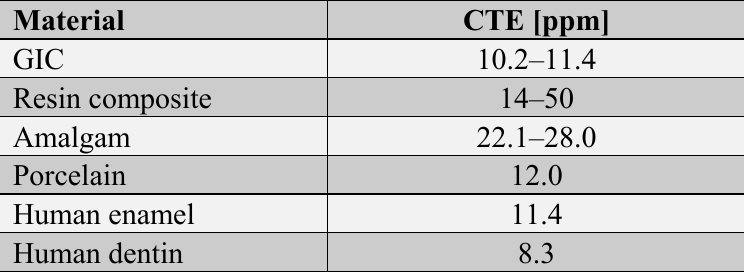
Table 2. Linear coefficients of thermal expansion of dental restoratives measured between 20 °C and 60